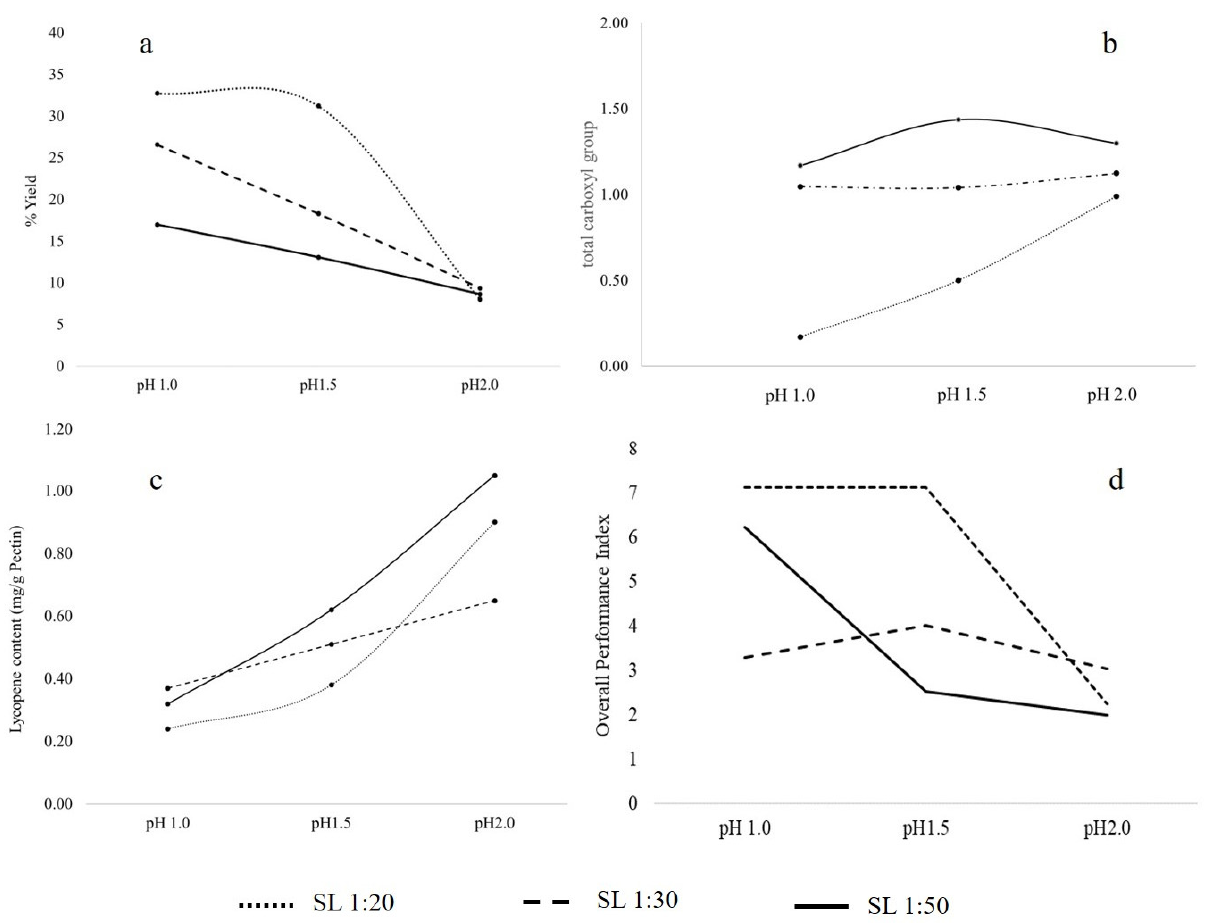
Figure 1. The pectin yield ( a ), total carboxyl group ( b ) and lycopene content ( c ), and overall perfor- mance index ( d ) of each condition .